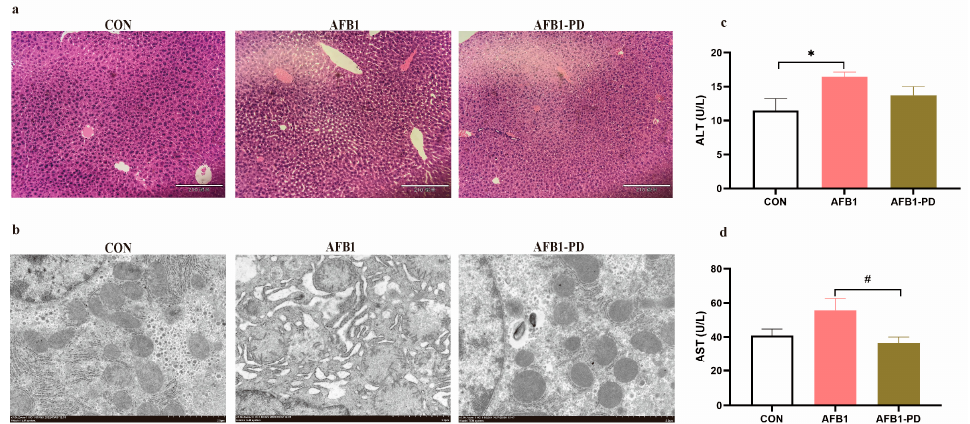
Figure 1. Polydatin (PD) alleviates hepatic injury in aflatoxin B1 (AFB1) mice. ( a ) The HE-stained liver tissues, scale bar = 210 µm; ( b ) the hepatic ultrastructure, scale bar = 2 µm; ( c ) serum alanine transaminase (ALT) activity; ( d ) serum aspartate transaminase (AST) activity. CON, mice are given 0.5% dimethyl sulfoxide; AFB1, mice are given 300 µg AFB1/kg body weight/day; AFB1-PD, mice are given 100 mg PD/kg body weight/day and then exposed to AFB1. Results are represented as mean and standard error (n = 4). * p < 0.05 when compared with the CON group, # p < 0.05 when compared with the AFB1 group.